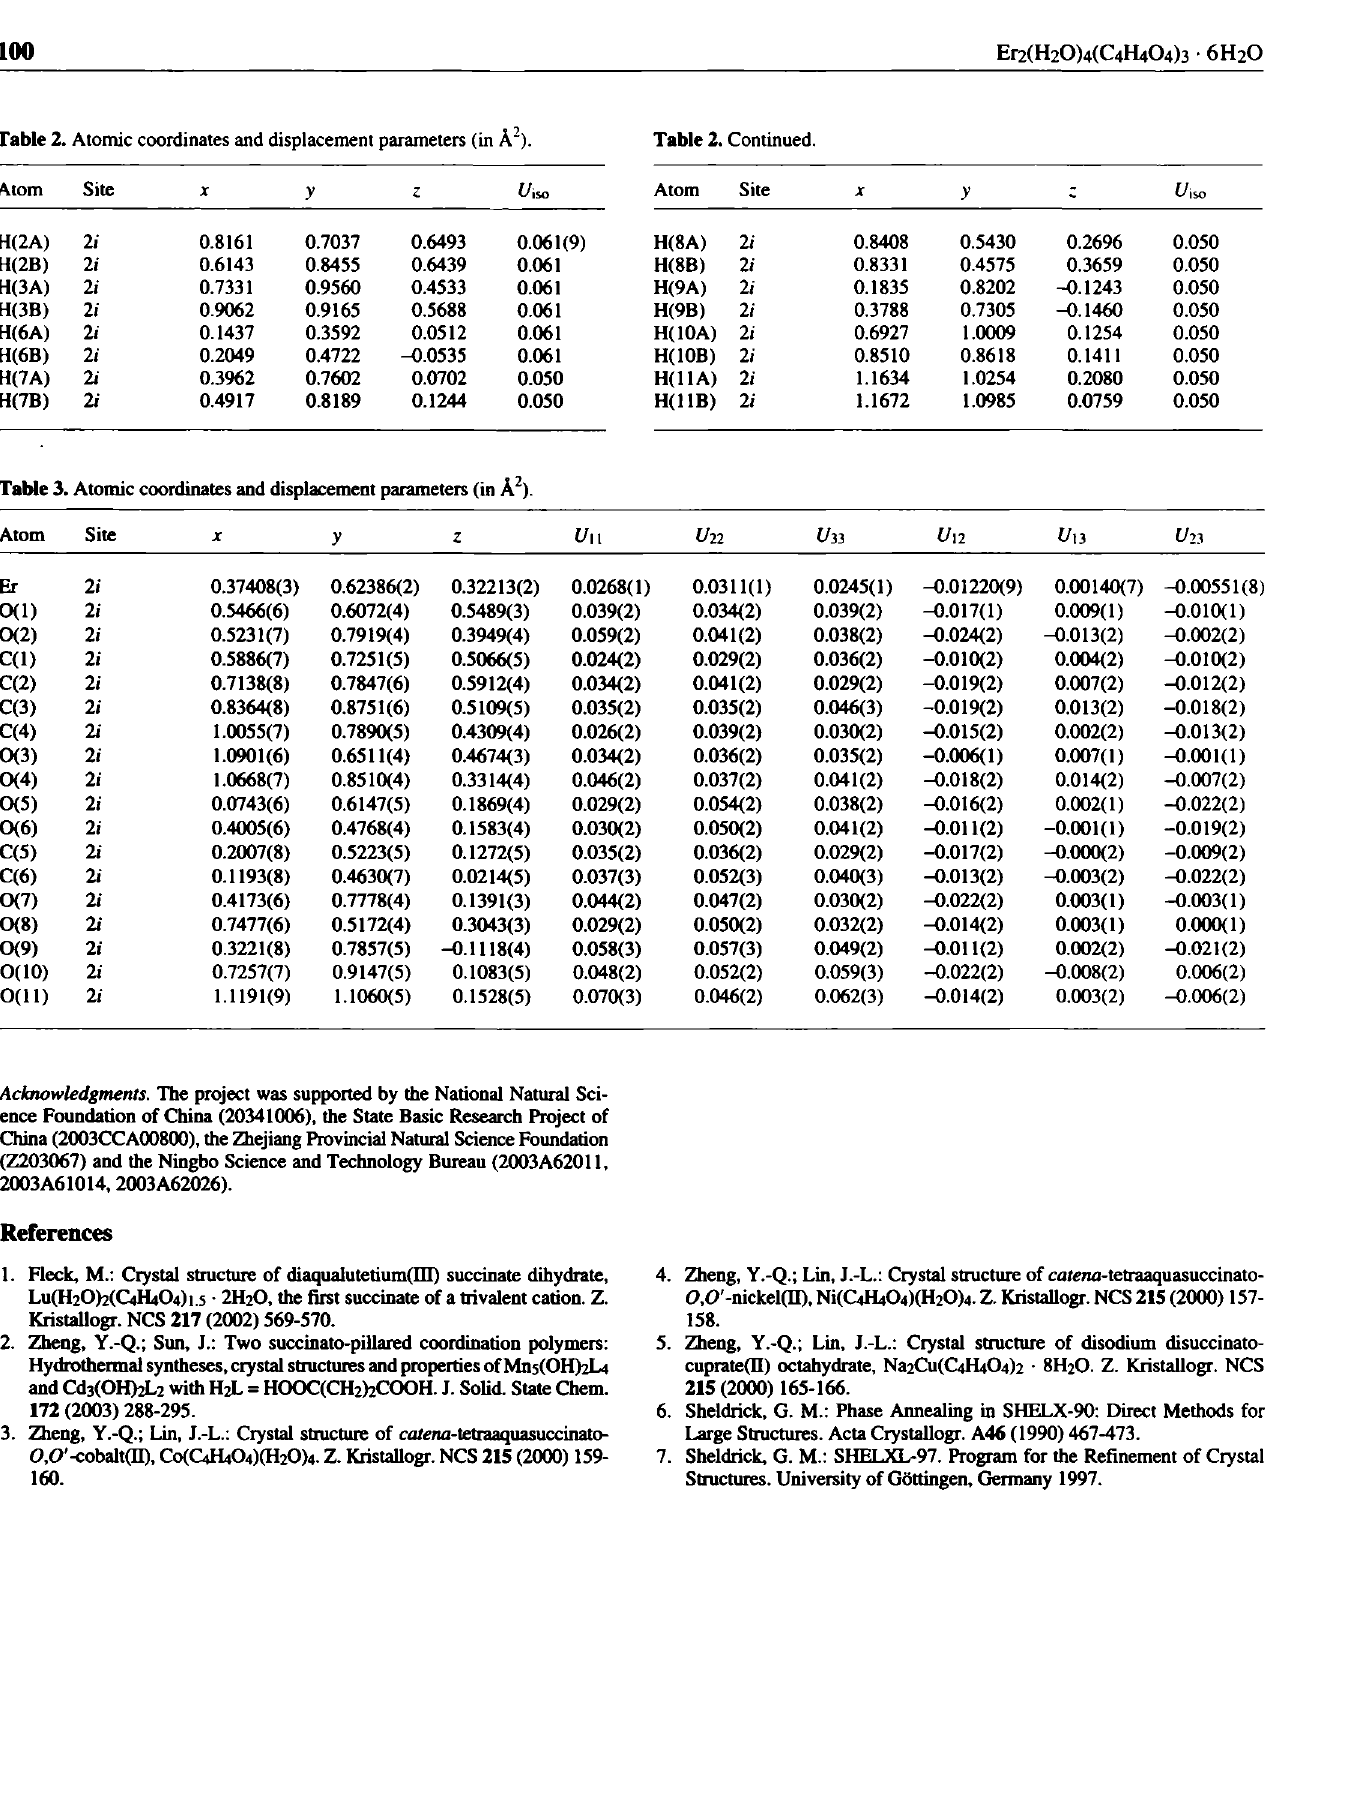
Table 2. Atomic coordinates and displacement parameters (in À 2 ).